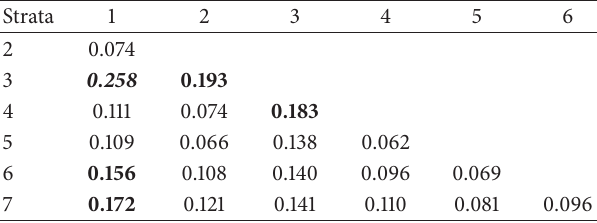
Table 3: Average pairwise Fst among seven strata with Nothofagus dombeyi presence in Chile based on a set of 10,109 single nucleotide polymorphisms (SNP). Fst 0.15–0.2 are moderately differentiated in bold font and Fst > 0.25 are considered strongly differentiated in bold and italic